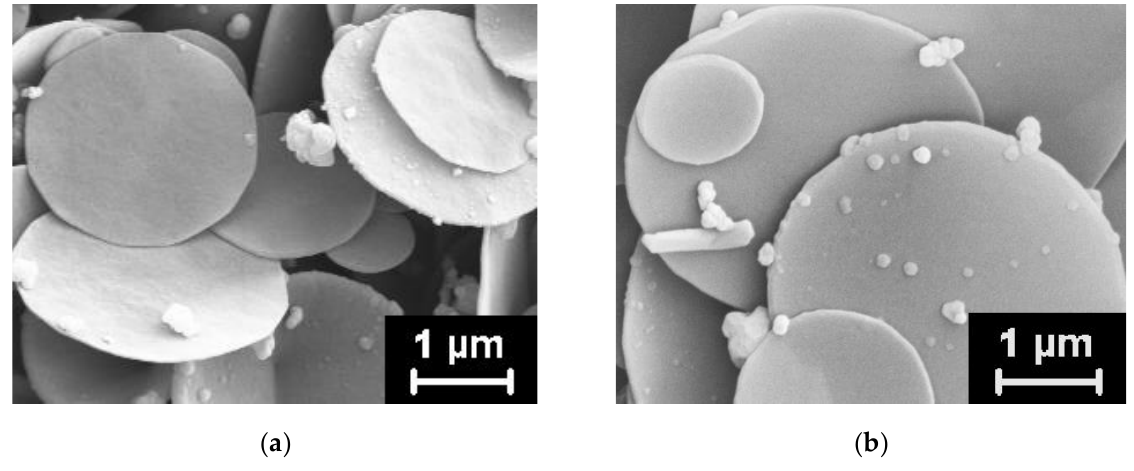
Figure 3. Micrographs of the original ( a ) and high-temperature annealed ( b ) nanodiscs.